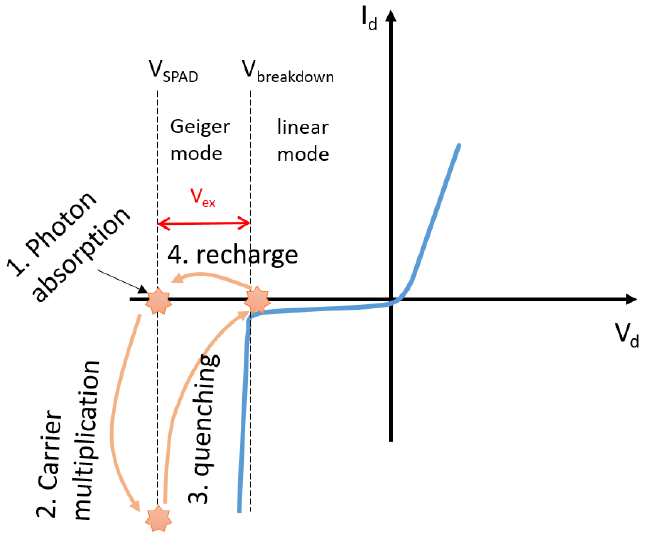
Figure 13. Current–voltage (IV) characteristic curve of an avalanche photodiode operated in Geiger